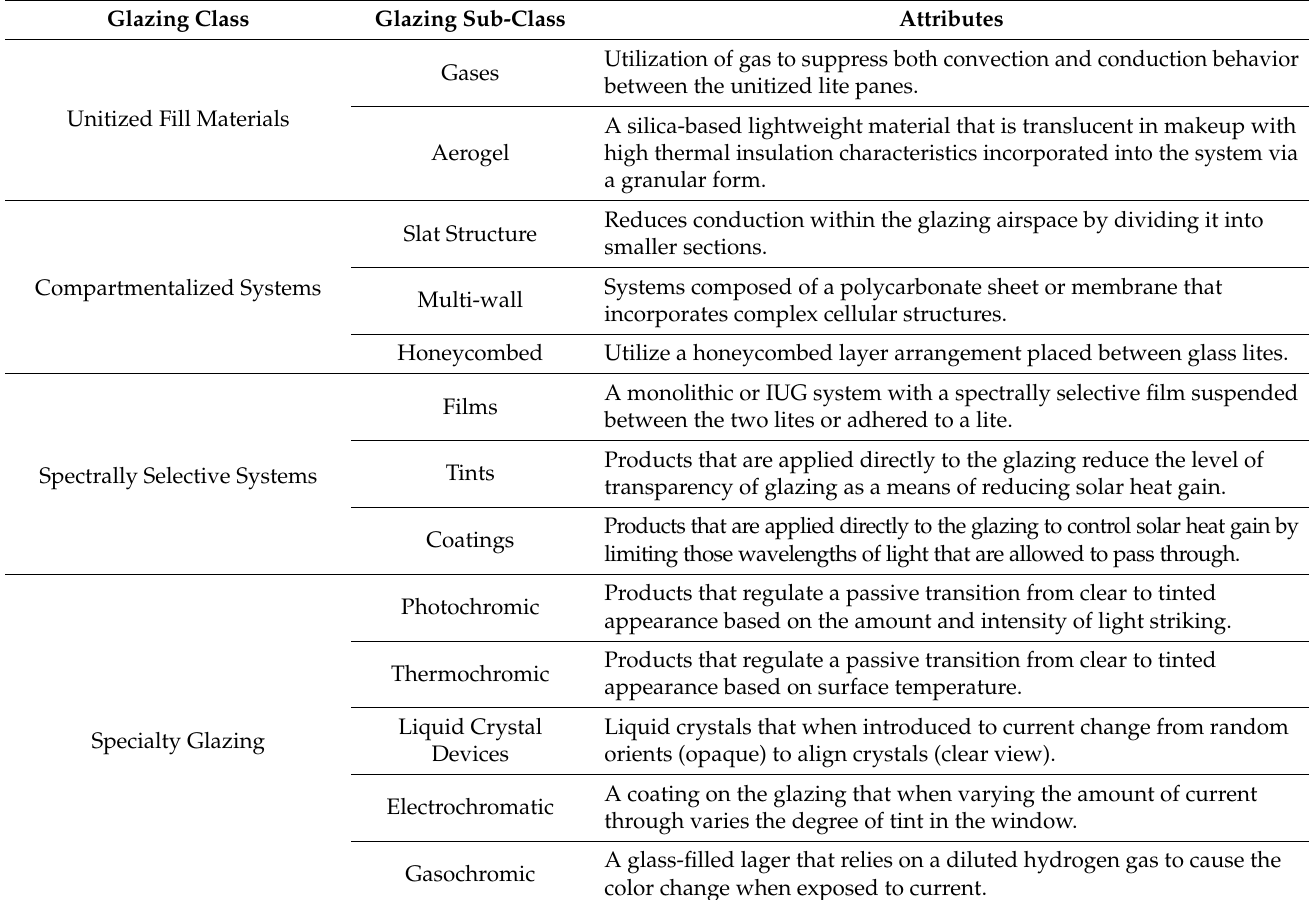
Table 6. Available Glazing Technologies (adapted from Ariosto et al.